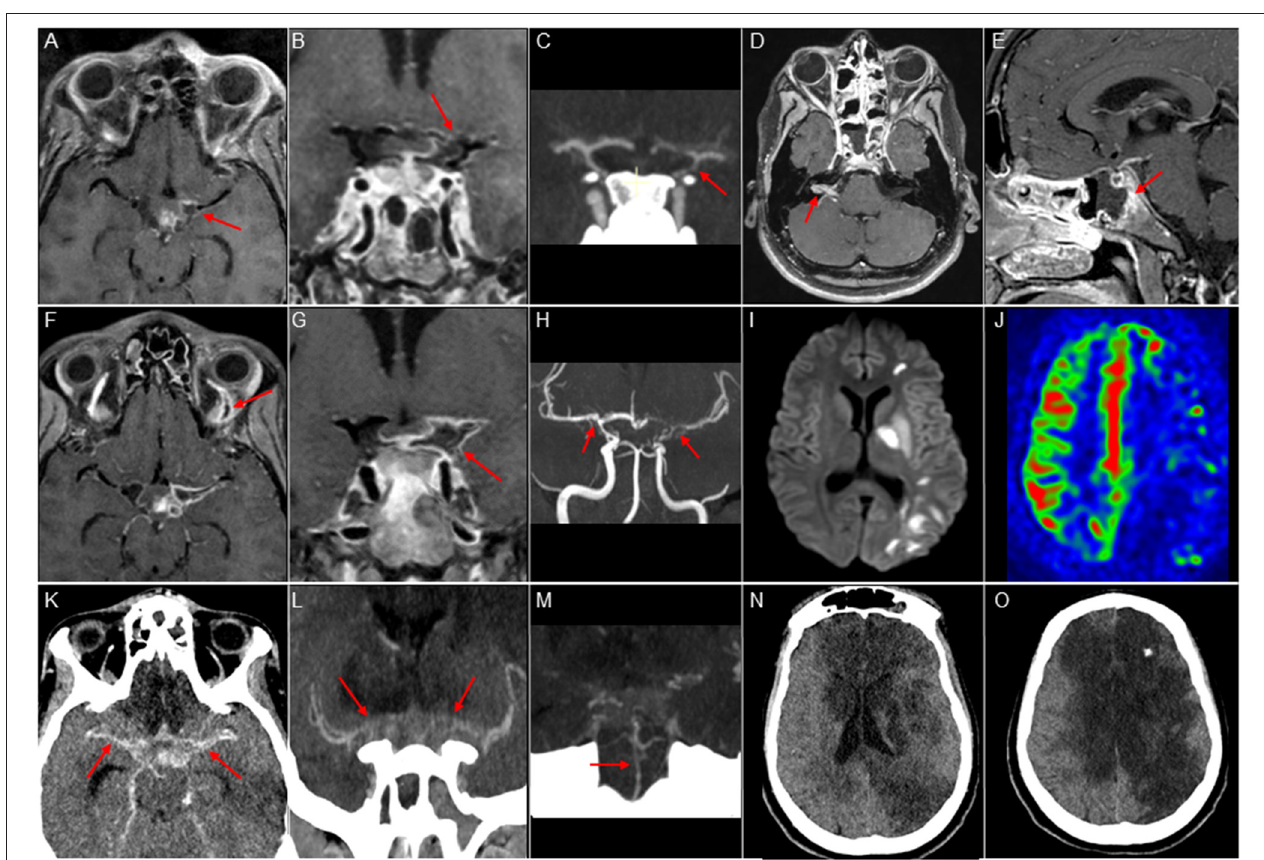
FIGURE 1 | Imaging features. Upper panel: MRI and CT scan at admission. (A,B,D,E) : Cube T1 FatSat post Gadolinium contrast, axial (A,D) , coronal (B) , and sagittal (E) views. (C) : Contrast-enhanced CT with arterial phase, coronal view. Vasculitis of the Circle of Willis: stenosis of the left internal carotid artery, middle cerebral artery, and anterior cerebral artery (A-C) , with vessel wall enhancement (A,B) . Right acoustic-facial neuritis ( D , arrow), sphenoid sinusitis with adjacent osteitis ( E , arrow). Medium panel: MRI after sudden right hemiplegia and aphasia. (F,G) Cube T1 FatSat post Gadolinium contrast, axial view; (H) 3D Time-of-Flight angio-MR coronal view; (I) DWI sequence, axial view; (J) Arterial Spin Labeling perfusion sequence, axial view. Recent arterial ischemic stroke in the left middle cerebral territory (I) with extended hypoperfusion (J) , worsening of severe and bilateral vasculitis (F-H) , and left ophthalmic vein thrombosis ( F , arrow). Lower panel: CT scan at day 14. (K) : post-contrast axial view; (L,M) angio-CT coronal view; (N,O) : axial view. Worsening of the intracranial vasculitis (K-M) , with basilar artery involvement (M) . Large bilateral infarcts in anterior and middle cerebral artery territories (N,O)